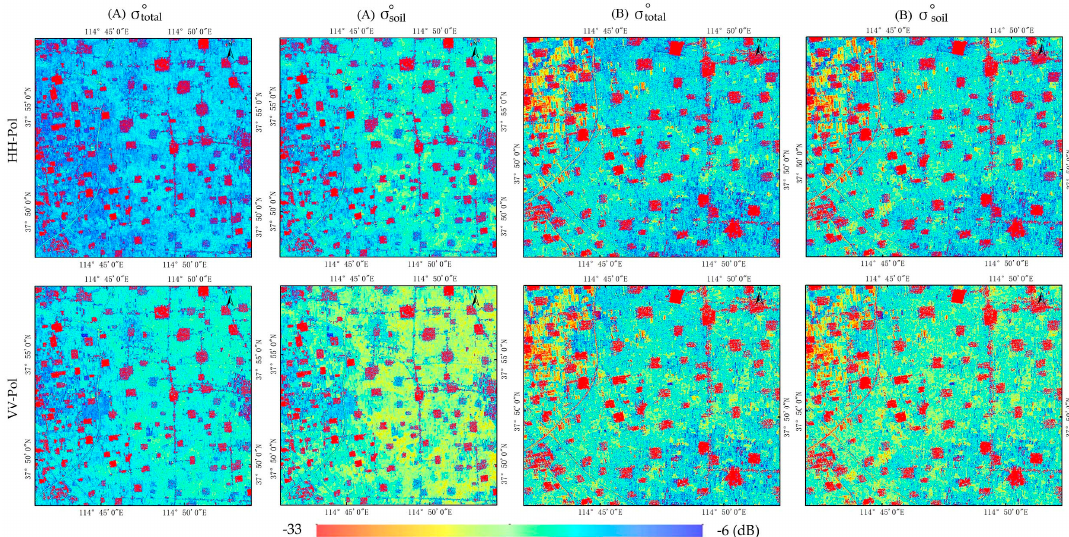
Figure 7. GF-3 satellite backscattering coefficient image ( (cid:2026) (cid:3047)(cid:3042)(cid:3047)(cid:3028)(cid:3039)° ) before and ( (cid:2026) (cid:3046)(cid:3042)(cid:3036)(cid:3039)° ) after